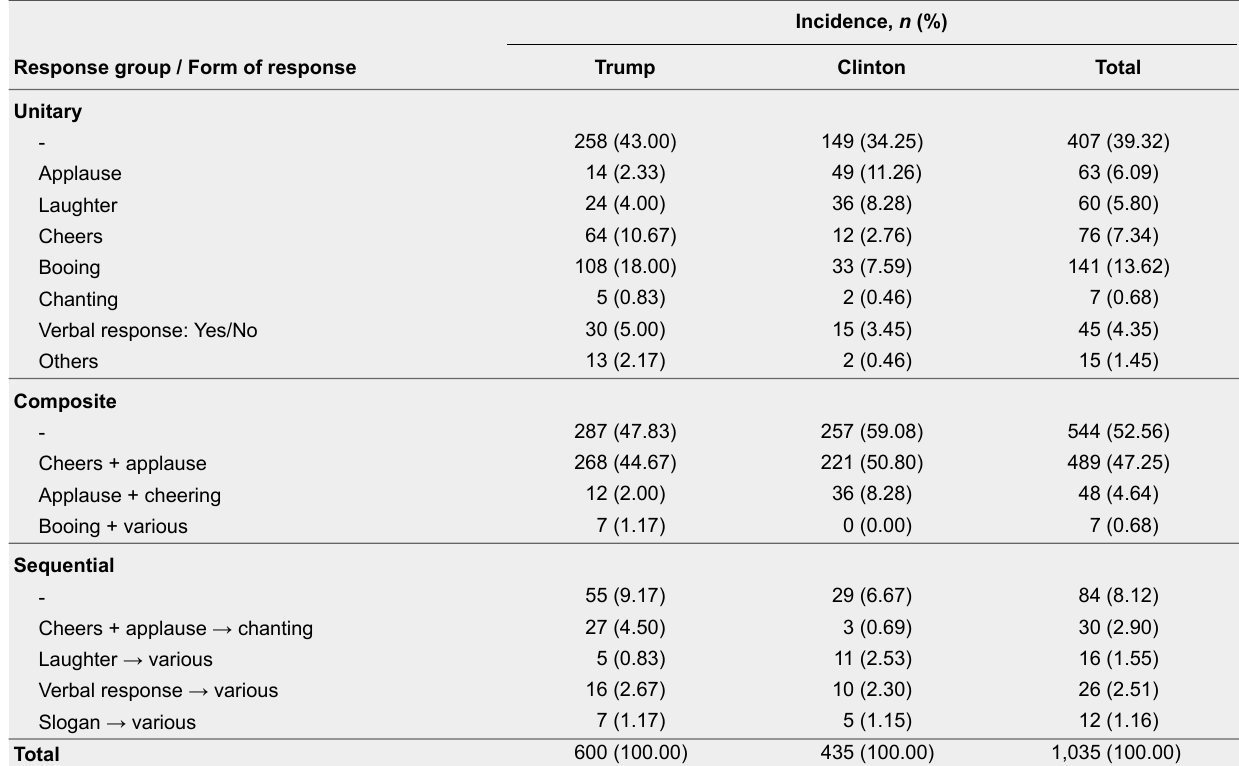
Summary of the Incidence Totals for Response Groups and Corresponding Sub-Categories Evoked by Each